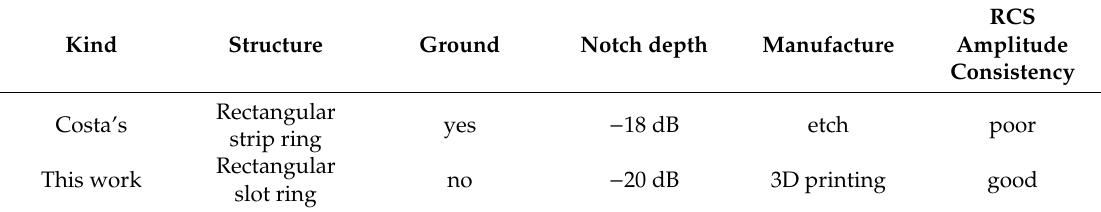
Table 3. The Comparison between Costa’s and this work.